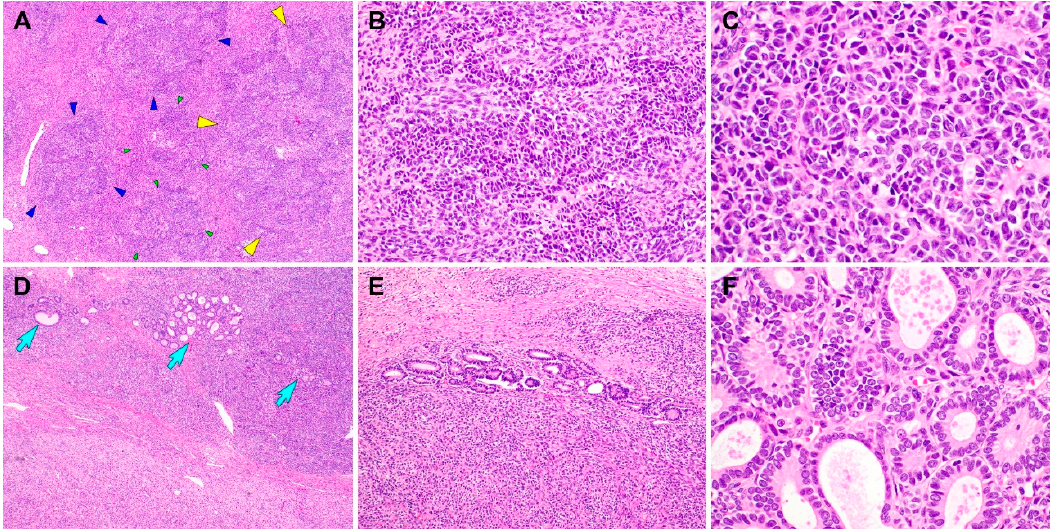
Figure 3. Histological findings of the Sertoli–Leydig cell tumor (SLCT) component of gynandroblastoma. ( A ) Moderately differentiated SLCT shows a multilobulated growth pattern on low-power magnification, with areas of alternating hypo- and hypercellularity. Each of the variable-sized lobules is outlined by green, blue, or yellow arrowheads. ( B ) The proliferating Sertoli cells form cords, solid tubules, and nests. ( C ) On high-power magnification, the Sertoli cells exhibit oval-to-spindle-shaped, hyperchromatic nuclei with mild atypia and a scant cytoplasm. ( D , E ) In several foci, loosely aggregated or individually scattered Sertoli tubules with open or compressed lumina (blue arrows) are readily identified. ( F ) The lining cells are low columnar-to-cuboidal cells and lack significant nuclear atypia. No evidence of poorly differentiated SLCT, a heterologous component, or coagulative tumor cell necrosis is observed. The hematoxylin and eosin stain were used ( A – F ). The original magnifications were 40× in A , 200× in B , 400× in C , 40× in D , 100× in E , and 400× in F .